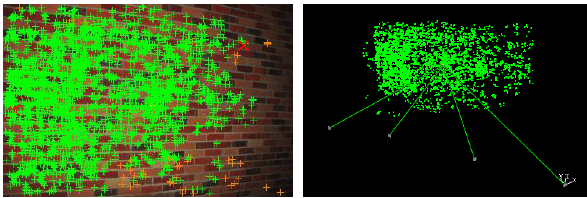
Figure 7. A characteristic image of the photogrammetric network along with the resultant object space.